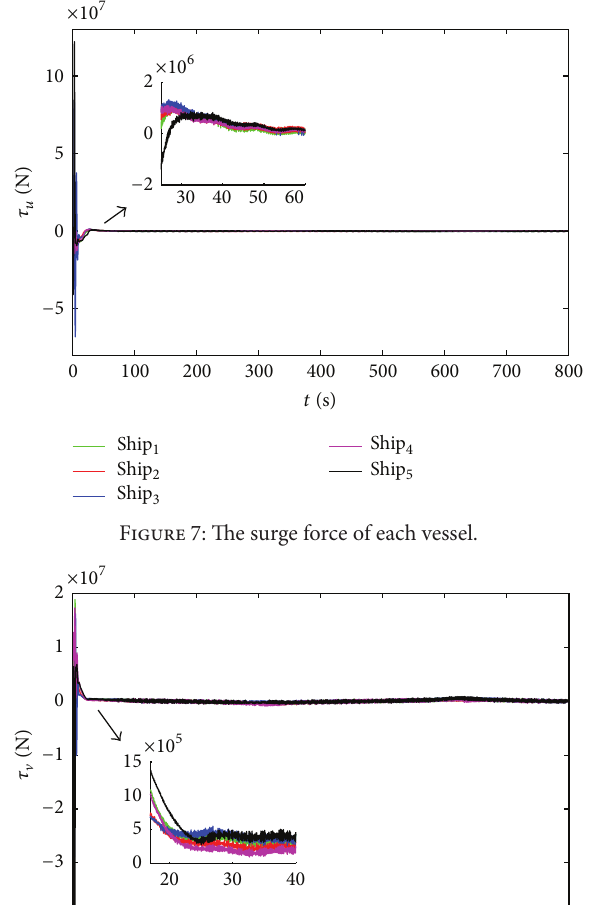
Figure 8: The sway force of each vessel.